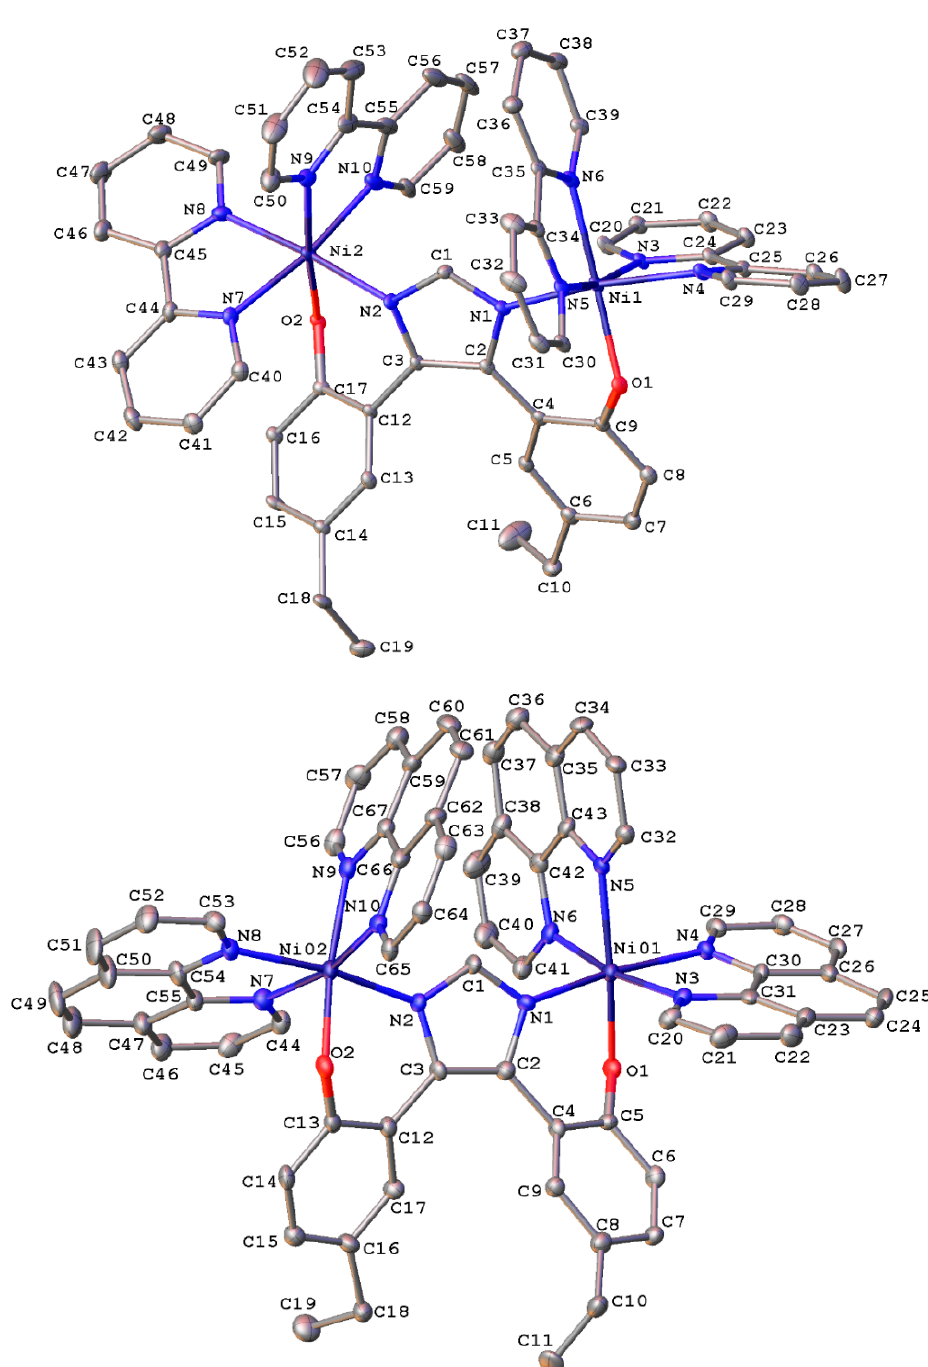
Figure 1. General view of the complex cations [(bipy) 4 Ni 2 (L)] + ( top ) and [(phen) 4 Ni 2 (L)] + ( bottom ) in representation of atoms via thermal ellipsoids at 20% probability level. Hydrogen atoms and minor components of the disordered ethyl groups in [(phen) 4 Ni 2 (L)]Cl are omitted. Table 1. Main geometrical parameters * of [(bipy) 4 Ni 2 (L)]Cl•CH 3 OH•0.75Et 2 O and In the crystal of the solvated complex [(bipy) 4 Ni 2 (L)]Cl , both the C-O bonds of the [(phen) 4 Ni 2 (L)]Cl •3CH 3 OH . ligand L form hydrogen bonds with the lattice methanol (O . . . O 2.621(6) and 2.569(5) Å, OHO 162.5(4) and 171.4(3) ◦ ). In the case of [(phen) 4 Ni 2 (L)]Cl , only one of them is involved in such a bond (O . . . O 2.695(7) Å, OHO 162.7(3) ◦ ); the two other solvent molecules of methanol are hydrogen-bonded to the first methanol molecule (O . . . O 2.721(7)